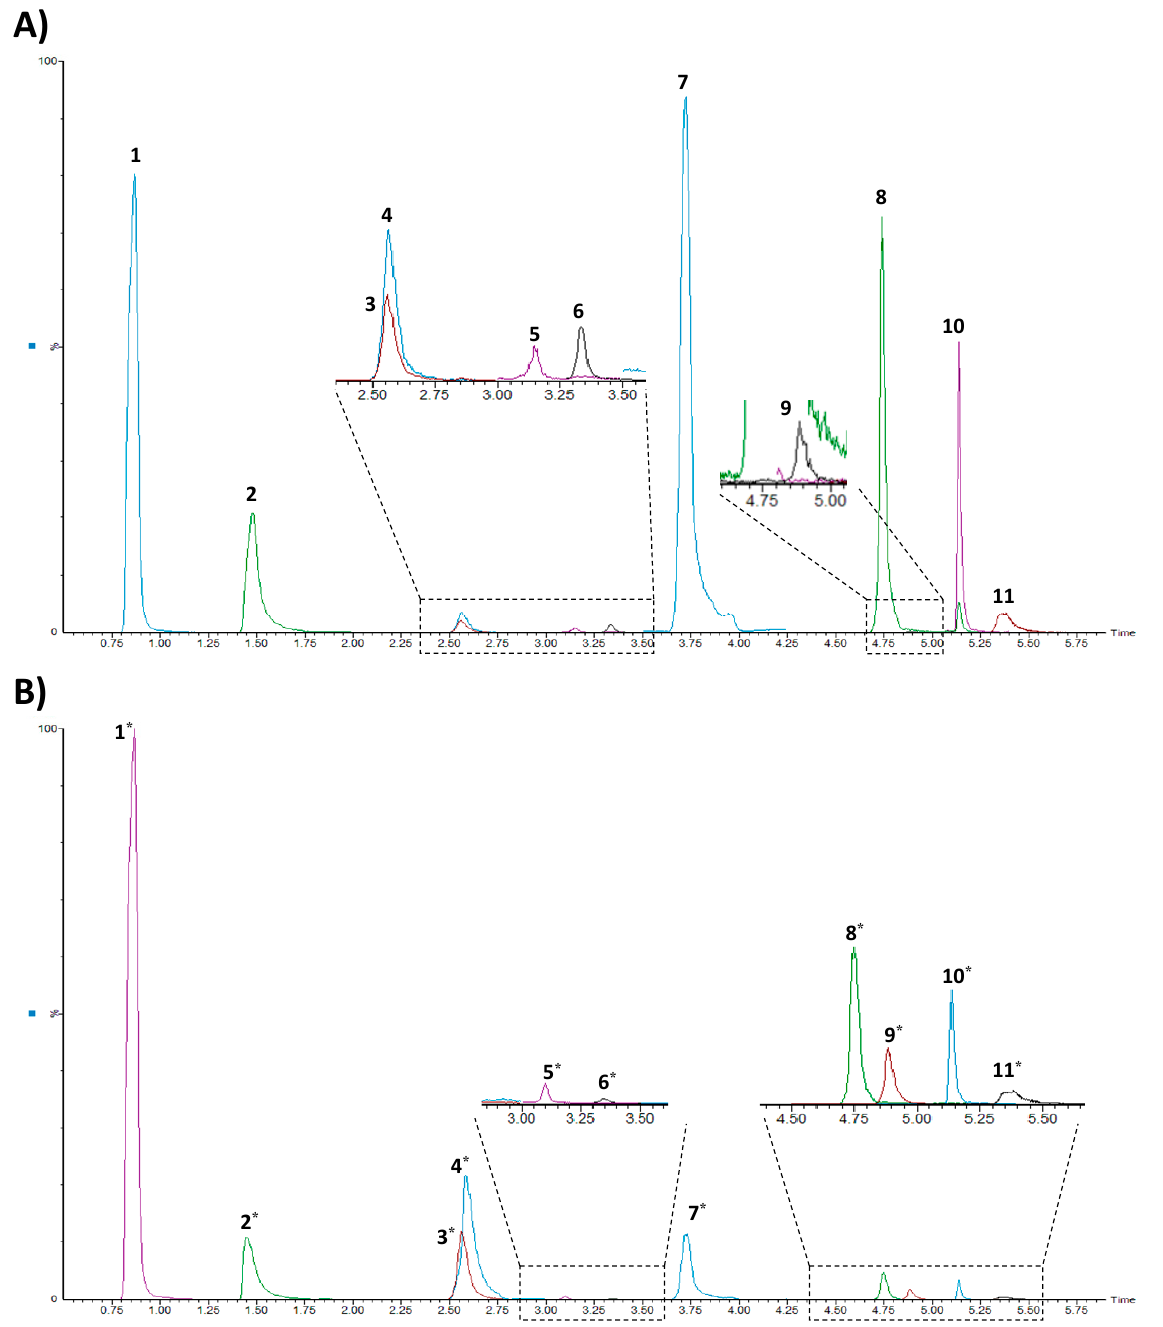
Figure 1. Overlapped SRM chromatograms of nine NT, tryptophan and kynurenine ( A ) and their internal standards ( B ) obtained from the analysis of quality control (QC) sample at the medium concentration level. 1—Ach, 2—Chol, 3—Trp, 4—Kyn, 5—PyroGlu, 6—NAA, 7—GABA, 8—Gln, 9—Asn, 10—Glu, 11—Asp, 1*—D 9 -Ach, 2*—D 9 -Chol, 3*—D 5 -Trp, 4*—D 4 -Kyn, 5*—D 5